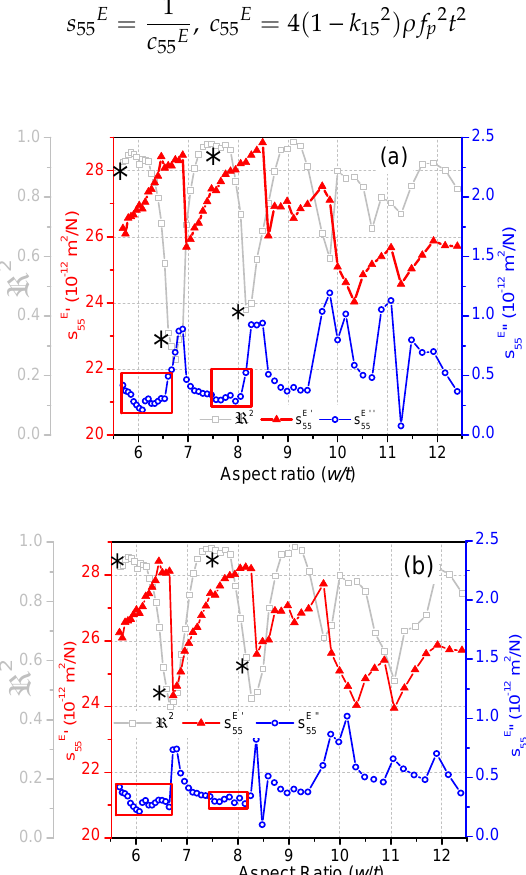
Figure 8. Evolution of the complex elastic compliance s 55E as a function of the aspect ratio of the BCZT plate; the real and the imaginary parts (s 55E ´ and s 55E ´´) are both plotted for: ( a ) calculation by the automatic iterative method; ( b ) recalculation by the modified method. The evolution of R 2 is shown as a reference.